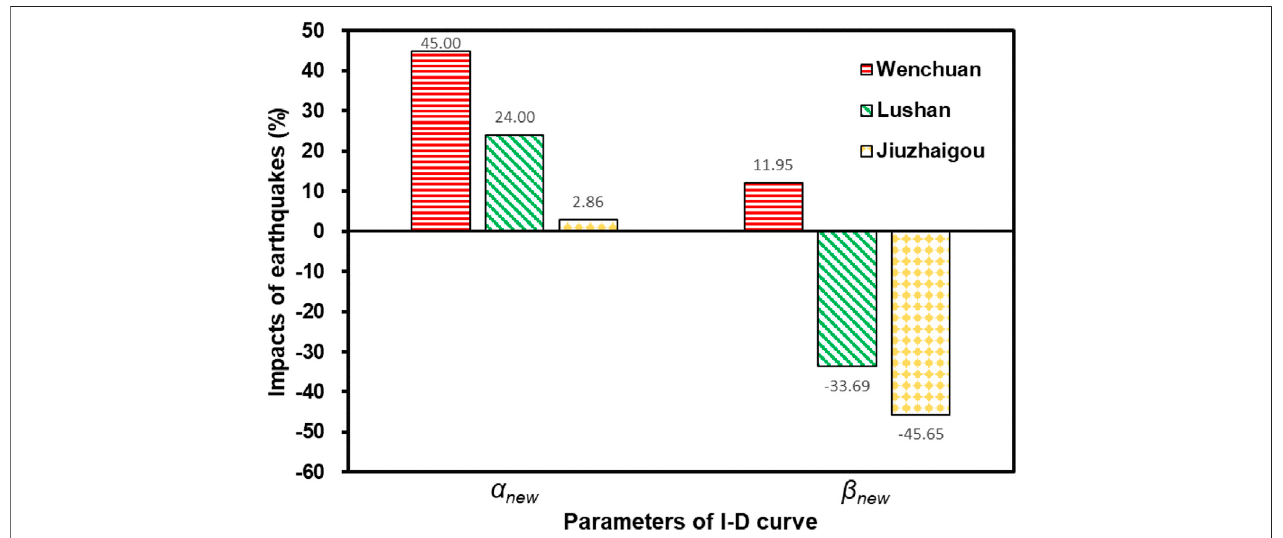
FIGURE 5 | Impacts of each earthquake on the I-D curve parameters for debris fl ows. The positive impact on α new indicates the decrease of the scaling constant. The positive impact on β new means the decrease of the shape slope.